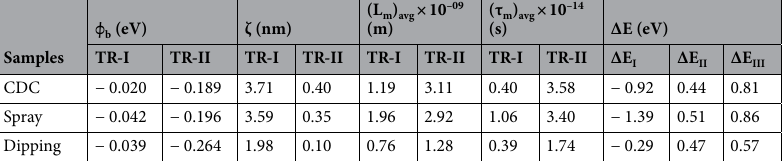
Table 3. Grain boundary barrier height